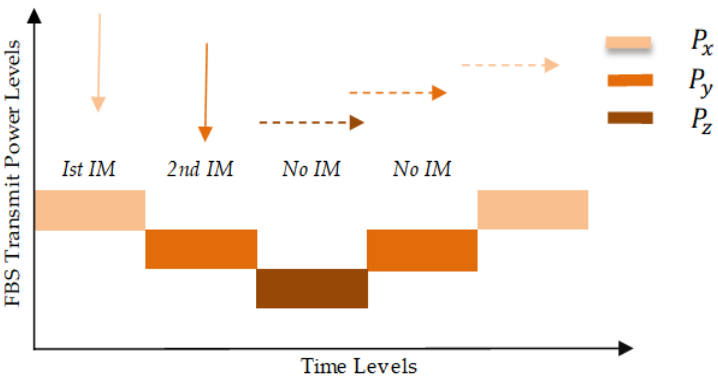
Figure 2. Femtocell transmit power tuning ( P x , P y and P z